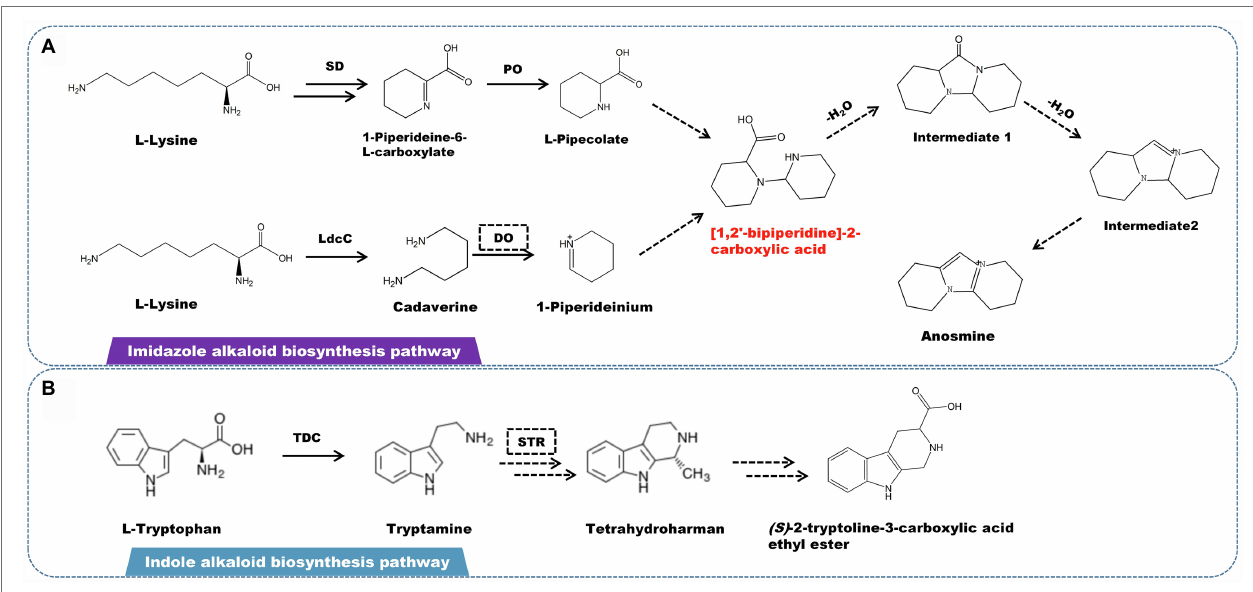
FIGURE 5 | A plausible biosynthesis pathway of imidazole and indole alkaloids. (A) The imidazole alkaloid biosynthetic pathway. (B) The indole alkaloid biosynthetic pathway. The dashed box represents the putative enzymes. The dashed arrow represents the speculated pathway. The multiple arrows represent